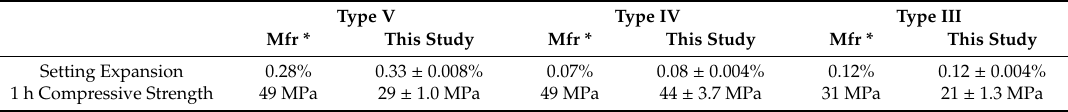
Table 1. Comparison of properties between manufacturer and this study (mean ± std